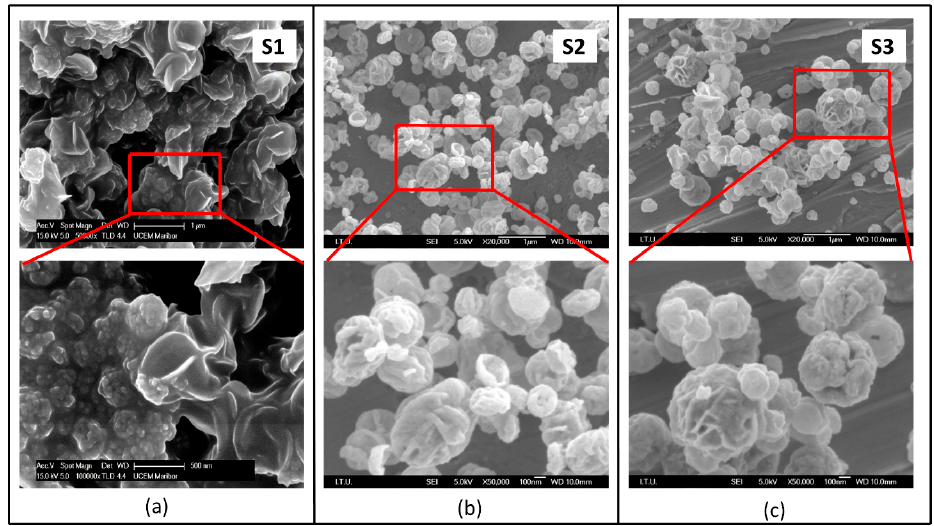
Figure 1. SEM micrographs of nanostructured ZnO particles ( a ) S1, ( b ) S2, and ( c ) S3, at 800 °C, 0.5 L/min of N 2 gas flow rate.